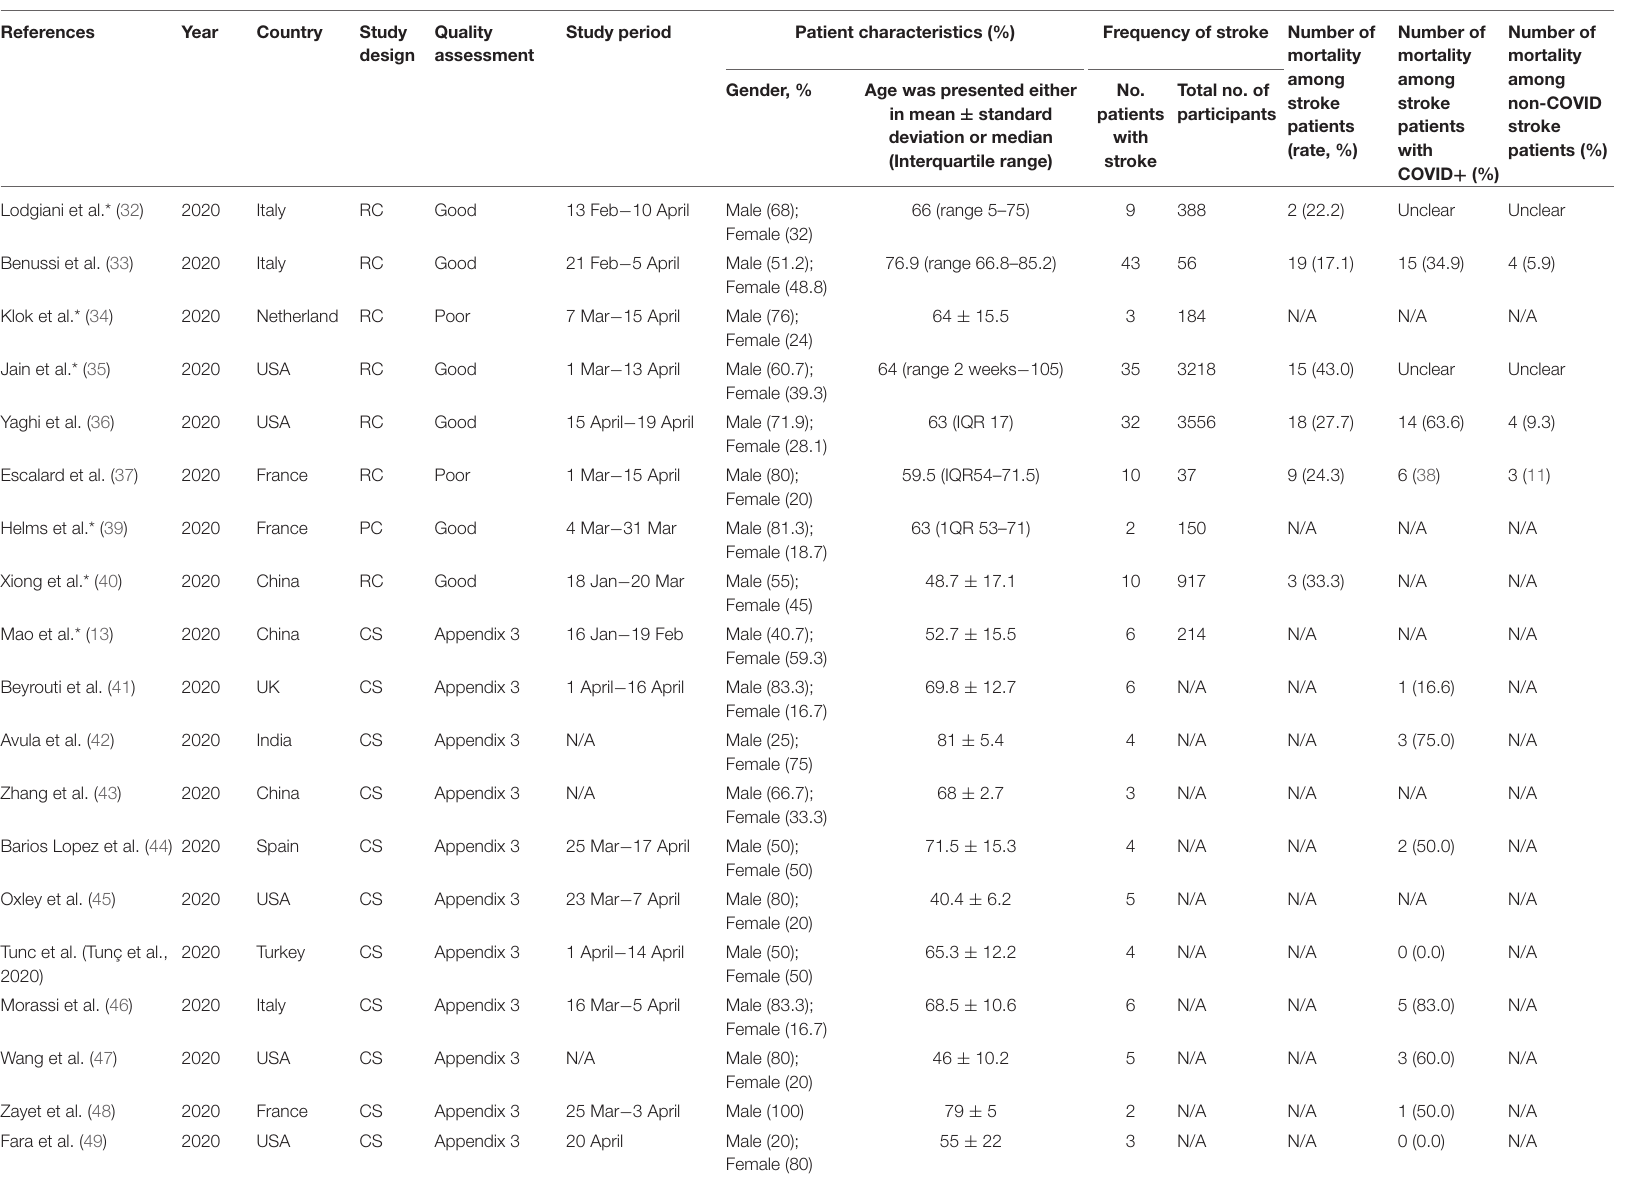
TABLE 1 | Characteristics of the included